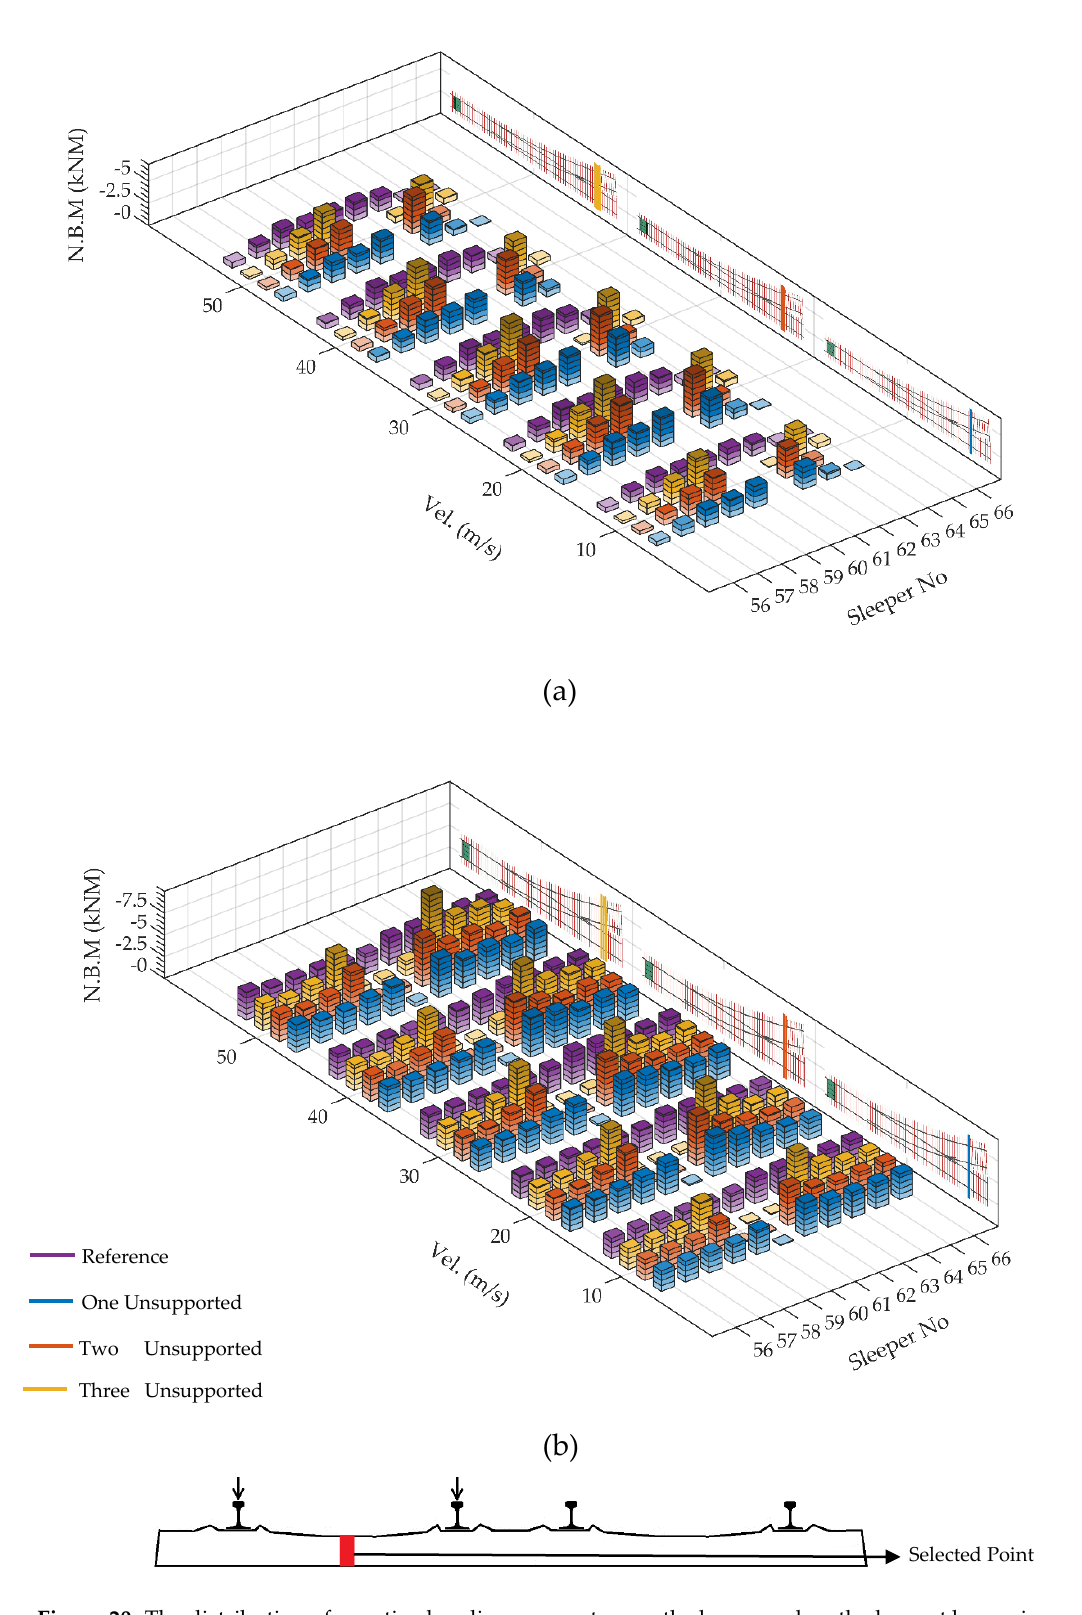
Figure 20. The distribution of negative bending moments over the bearers when the longest bearer is unsupported: ( a ) at particular time when the front wheel is on the bearer with number 61; ( b ) when maximum occurs at each bearer.